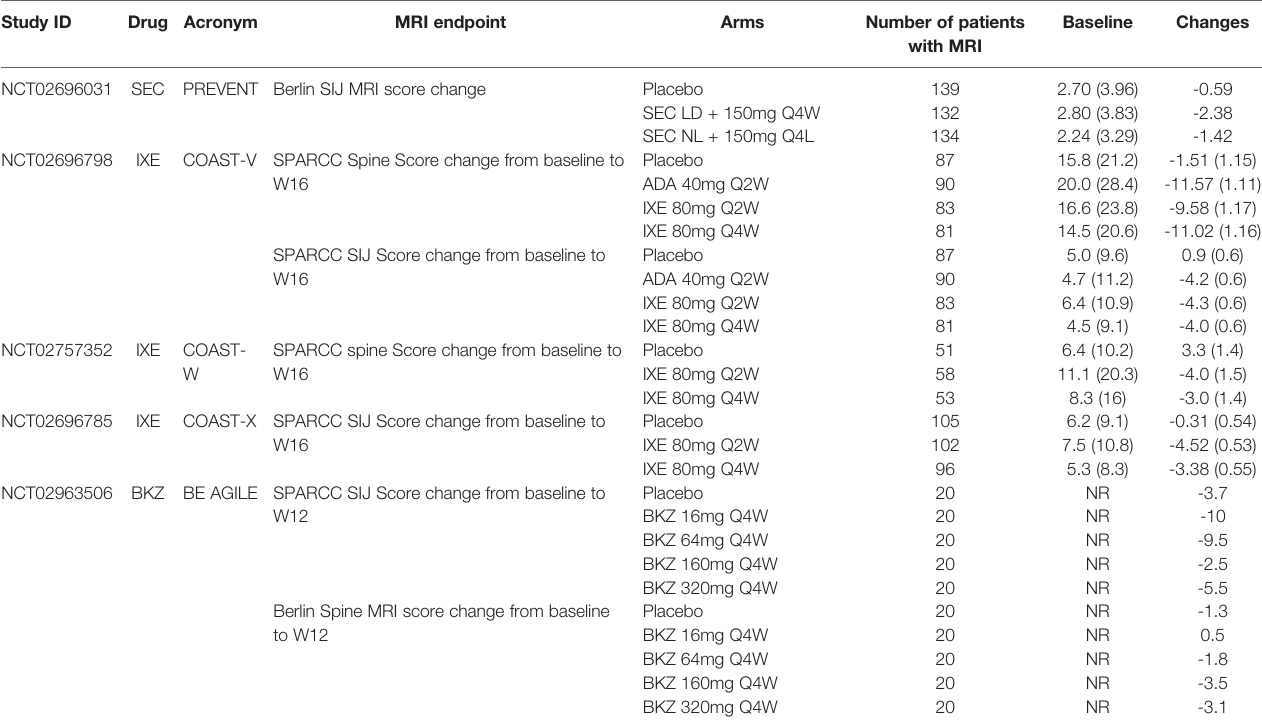
TABLE 2 | Spine or pelvis MRI score changes in IL-17i trials in axial spondyloarthritis. Study ID Drug